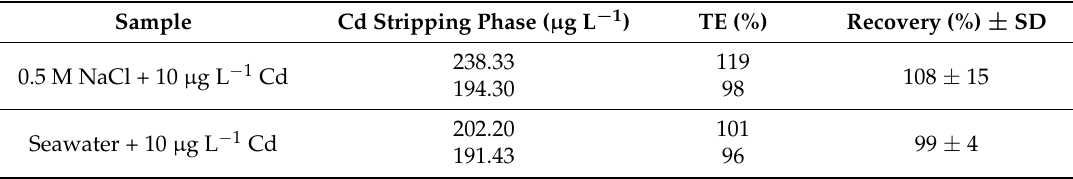
Table 2. Cd preconcentration using the PIM-device (24 h). PIM: 50% CTA + 10% THTDPCl + 40% NPOE.